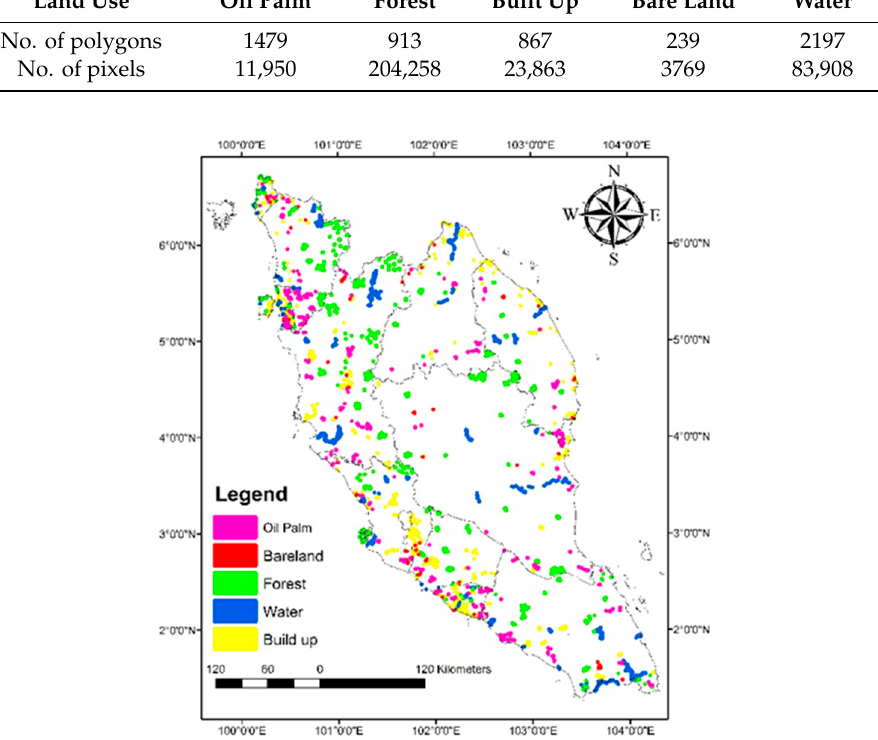
Figure 3. Locations of samples that were used in accuracy assessment of oil palm areas detected in Peninsular